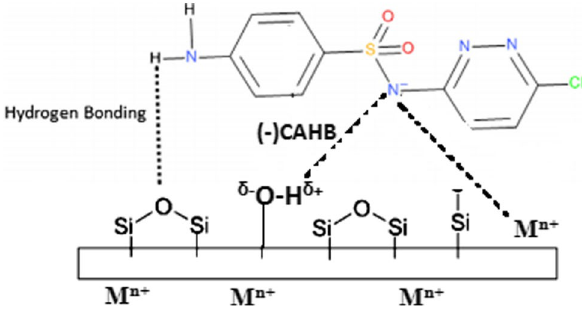
Fig. 10 Possible adsorption mechanism of SCP on